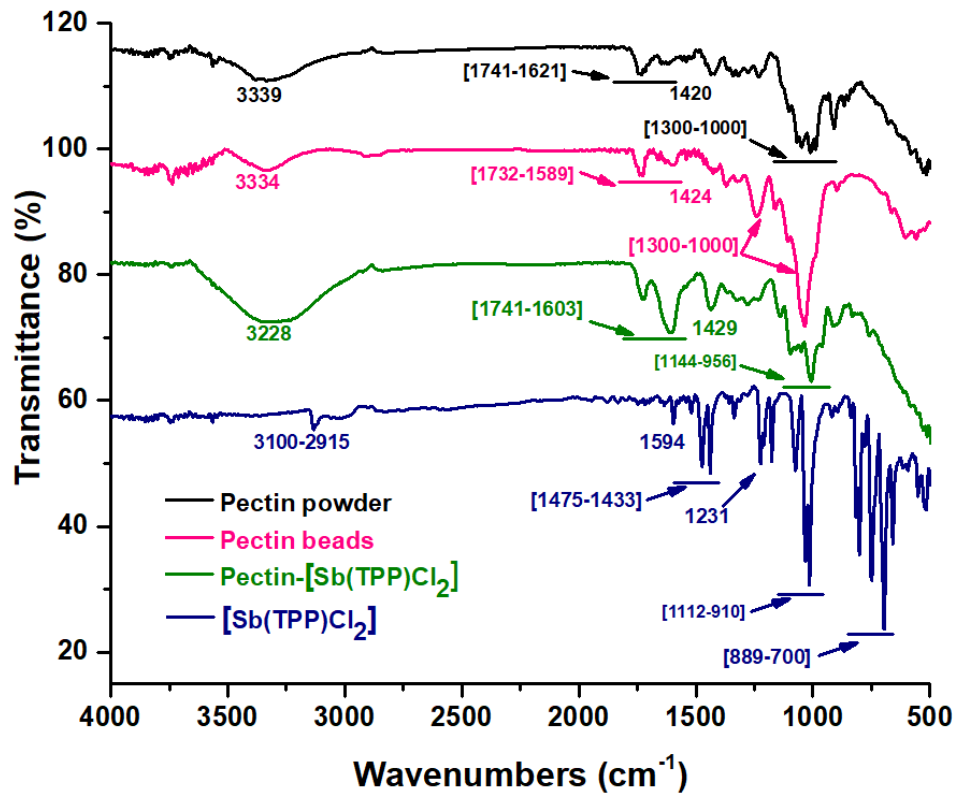
Figure 2. FT − IR spectrum of pectin powder, pectin beads, [Sb(TPP)Cl 2 ], and pectin − [Sb(TPP)Cl 2 ] (1%) composite beads.